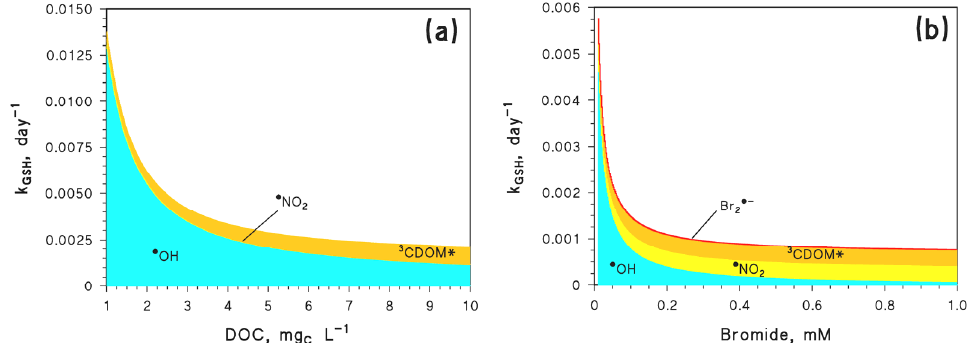
Figure 9. Pseudo-first order rate constants of the GSH’s indirect phototransformation, as a function of ( a ) the DOC, and ( b ) the bromide concentration. Other conditions (when the given parameter is not set to vary on the X-axis): 5 m water depth, 0.1 mM NO 3 − , 1 µM NO 2 − , 1 mM HCO 3 − , 10 µM CO 32- , 1 mg C L − 1 DOC, negligible Br − , and 22 W m − 2 sunlight UV irradiance (equivalent to fair weather, 45 ◦ N latitude 15 July, at 9 a.m. or 3 p.m.). The color code depicts the relative importance of the different phototransformation